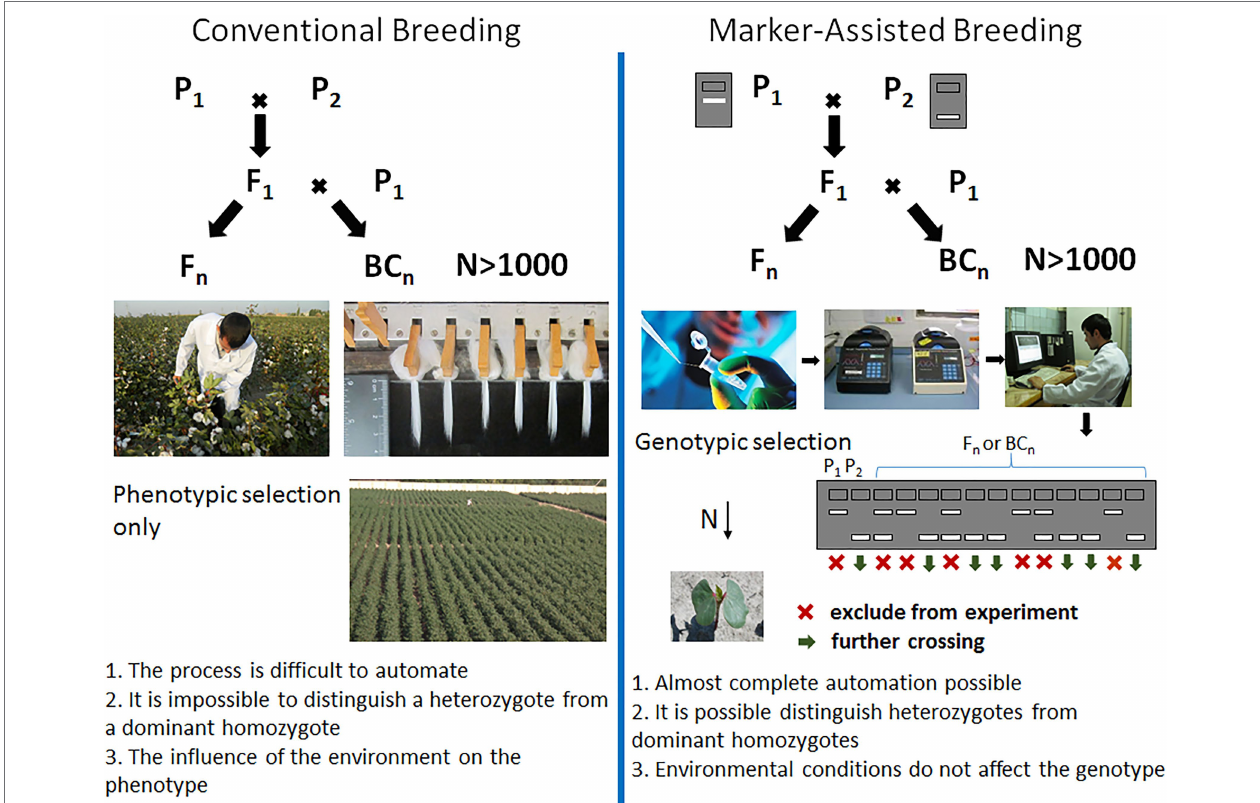
FIGURE 2 | Marker-assisted selection in comparison with conventional breeding. P 1 and P 2 – parental genotypes, F 1 – first generation hybrid, F n – hybrid progeny obtained from first generation by self-pollination, and BC n – backcross